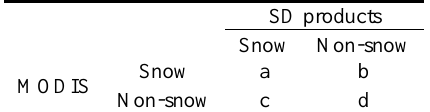
Table 1. Confusion matrix for remote sensing image vs. snow depth products.